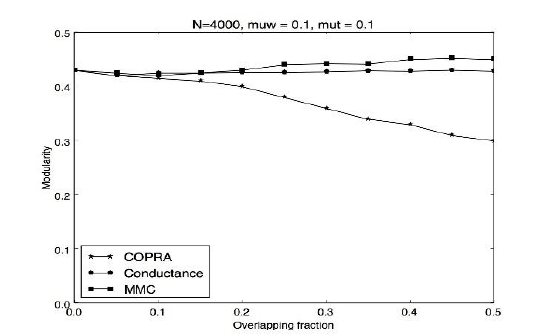
Figure 3. Modularity of the community structure detected by COPRA, Conductance and MMC while N= 4000 and muw=mut =0.1.